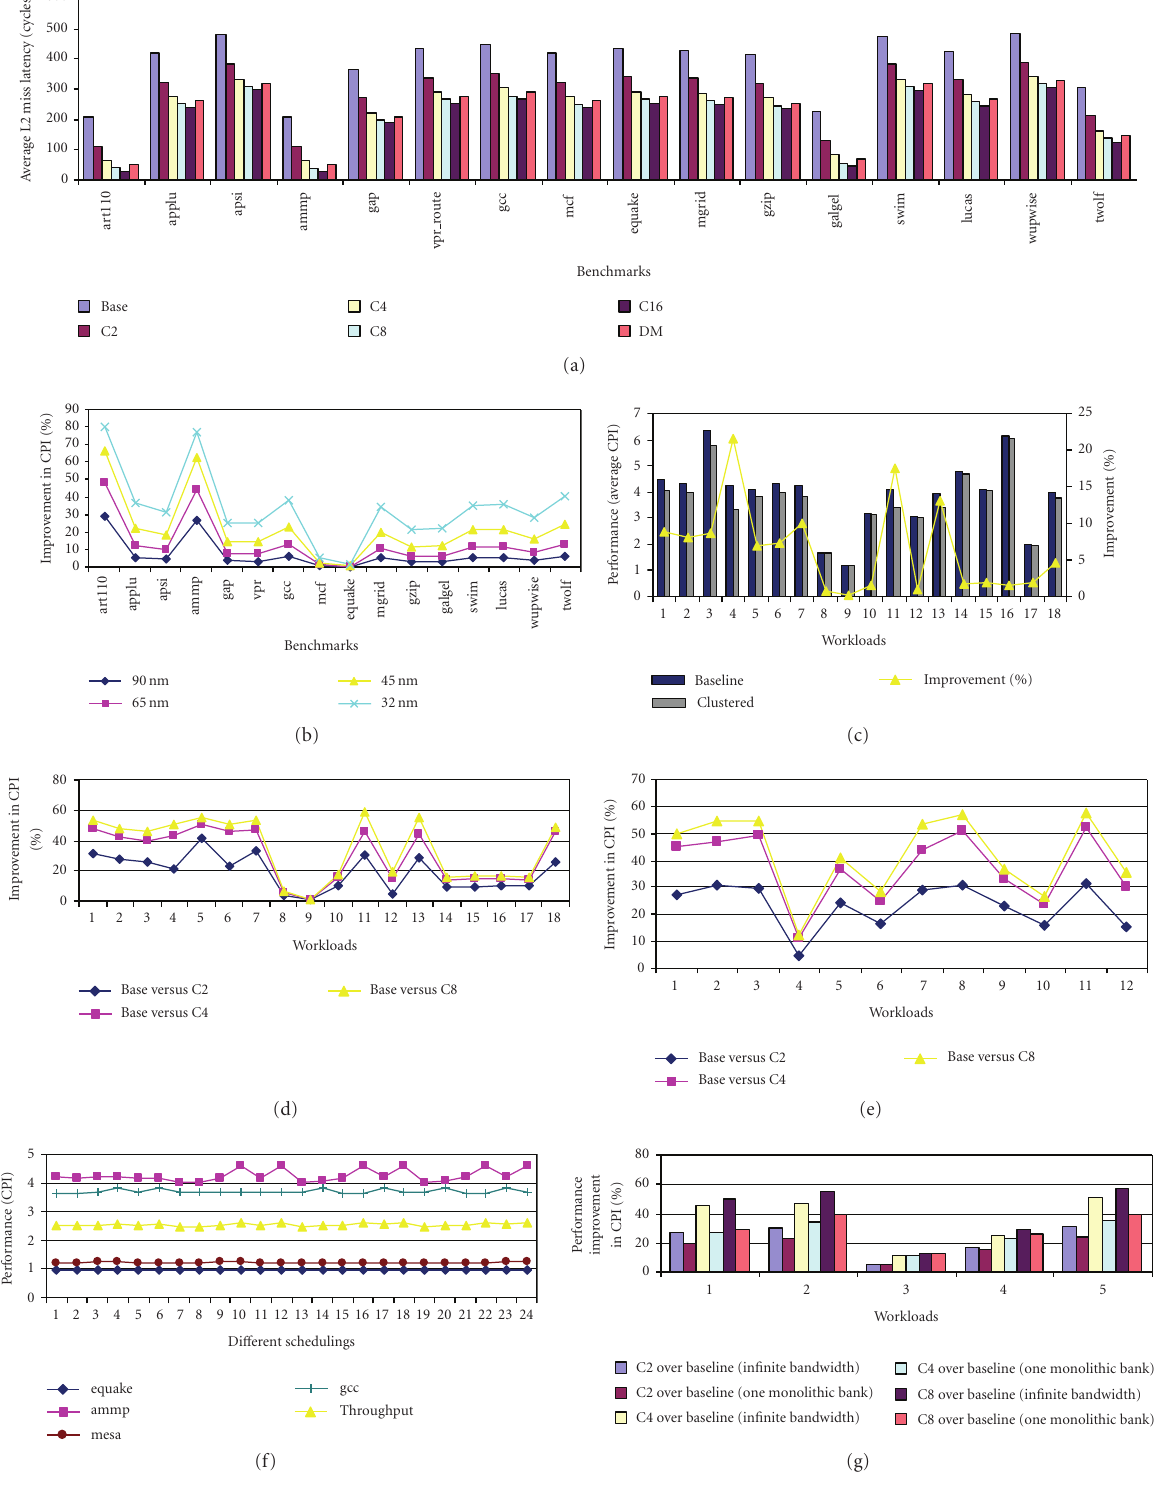
Figure 14: Performance improvement for multiprogramming workloads; (a) Average L2 miss latency for di ff erent architectures running single application (32nm); (b) Performance improvement for single application using a cluster of 2 cores and direct memory connection to the shared L3 cache; (c) Performance improvement for di ff erent architectures running 2 applications (90 nm); (d) Performance improvement for di ff erent architectures running two applications (45nm); (e) Performance improvement for di ff erent architecture running four applications (32nm); (f) Impact of scheduling on performance within a single cluster; (g) Impact of L3 bandwidth limitation on performance gained with